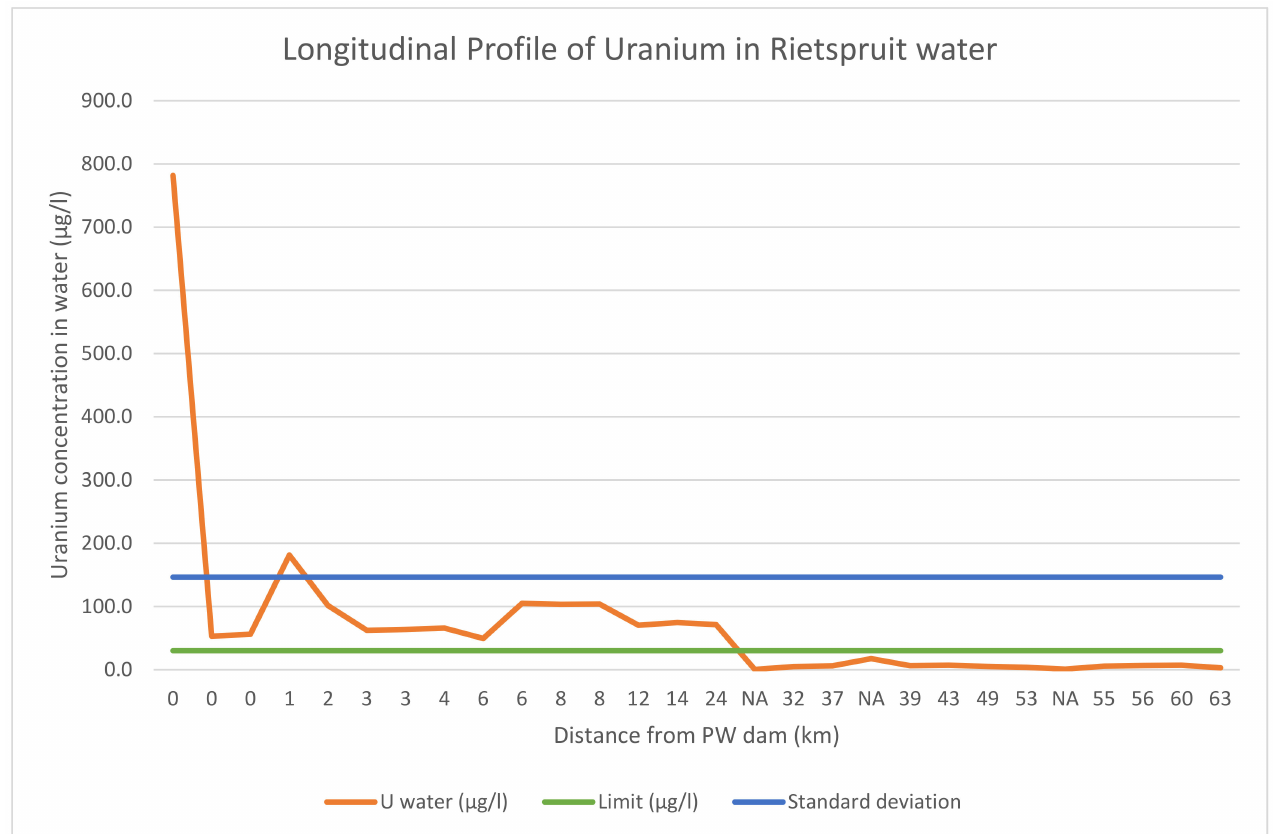
Figure 4. Longitudinal profile of U in Rietspruit